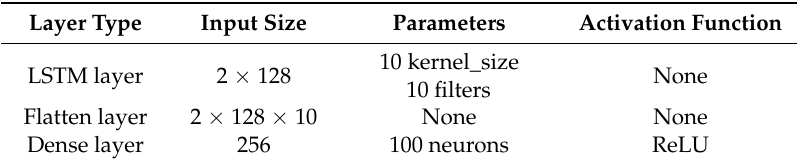
Table 2. Proposed encoder structure.